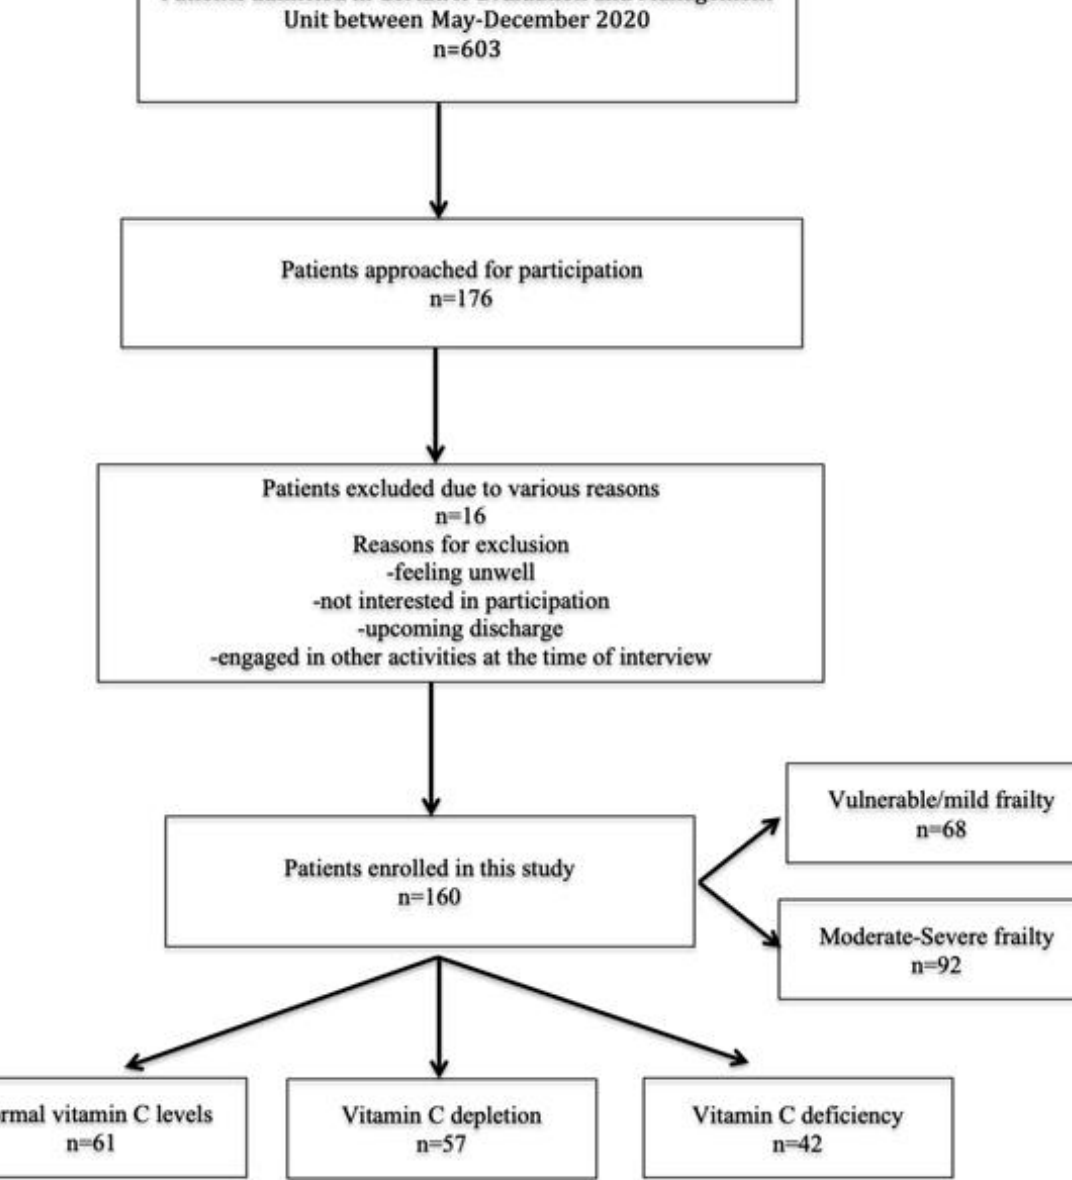
Figure 1. Study flow